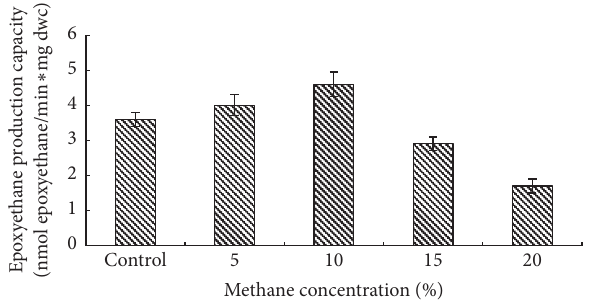
Figure 4: Effect of methane on the epoxyethane production capacity. Initial concentrations of ethylene and gas phase oxygen were maintained at 20% and 50%, respectively. Methane was diluted with nitrogen to produce different concentrations. Whole cell epoxyethane production capacity was assayed after 30 min of incubation.